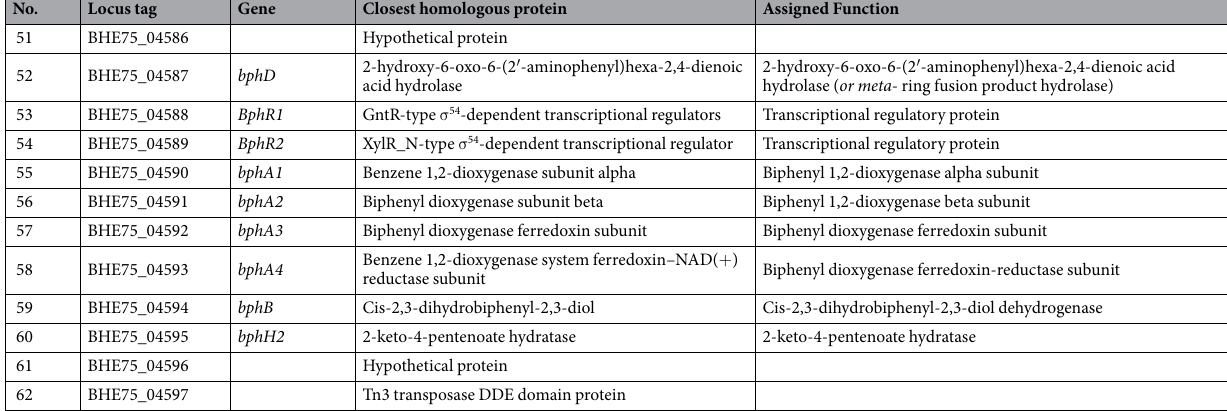
genes encoding the complete lower biphenyl ( bph ) pathway were found, including a 2-keto-4-pentanoate hydratase ( bphH1 ), an acetaldehyde dehydrogenase ( bphJ ) and a 4-hydroxy-2-oxovalerate aldolase ( bphI ). Denef et al . 27 have shown that a similar gene cluster in Burkholderia xenovorans LB400 was responsible for the transformation of 2-hydroxypenta-2,4-dienoate (produced by the hydrolysis of the 2-hydroxy-6-oxo-6-phenyl– 2,4-hexadienoic acid) to acetaldehyde and pyruvate. A transcriptional regulatory gene ( oppR ) showing high homology to a XylR_N superfamily of σ 54 -dependent transcriptional regulators was identified upstream of oppD1 (Table 1). This is in accordance with the regulation of the hpbCAD operon in P. azelaica which was operated by a σ 54 -dependent XylR/DmpR transcriptional regulator 26 . Operon 4 encodes an incomplete upper bph pathway (for the transformation of biphenyl to BA and 2-hydroxypenta-2,4-dienoate). This consists of bphA1A2A3A4 (multi-component biphenyl dioxygenase), bphB ( cis -biphenyl dihydrodiol dehydrogenase) and bphD (2-hydroxy-6-oxo-6-(2 ′ -aminophenyl)hexa-2,4-dienoic acid hydrolase), only missing bphC (2,3-dihydroxybiphenyl dioxygenase). The latter is known to be responsible for the transformation of biphenyl-2,3-diol to 2-hydroxy-2,4-pentadienoate and benzoate 28 . The upper bph pathway is ubiquitous in soil bacteria 29 and is usually found on transposable elements 30 . A second bphH2 and a gene encod- ing a second flavin-dependent monoxygenase (putative oppA2 ) were both located at the 5 ′ end of this operon. Two putative transcriptional regulatory genes were identified upstream of the bph genes ( bphR1R2 ). Phylogenetic analysis of the proteins encoded in the four catabolic operons provided insights into their origin and evolution. Operon 1 proteins (i.e. BenA, CatA, PcaD presented as indicative enzymes of the whole operon) clustered within the genus Sphingomonas and more specifically with proteins from a homologous operon of the HCH-degrading strain Sphingomonas MM1 31 (Supplementary Fig. S1). Their orthologs from operon 2 clustered with proteins found in bacteria from the wider sphingomonad complex ( Sphingobium and Novosphingobium ) (Supplementary Fig. S1). In contrast, proteins encoded in operons 3 (OppC, OppD1D2) and 4 (BphA3, BphB) were associated with taxonomically distant bacteria ( Burkholderiaceae , Streptomyces sp.) (Supplementary Fig. S2). These results suggest that the ben/cat operon 2 was laterally acquired by a member of the sphingomonad com- plex via horizontal gene transfer, in line with its flanking by tranposases. Whereas operons 3 and 4 constitute a patchwork assembly, with operon 4 probably still undergoing evolution as indicated by the lack of the bphC gene. Based on the genomic analysis of the S. haloaromaticamans strain P3, a putative metabolic pathway is pro- posed (Fig. 2a), where OPP is transformed to BA and 2-hydroxypenta-2,4-dienoate (operon 3). These are further transformed to Krebs cycle intermediates through the ben/cat ortho cleavage pathway (operons 1 or 2) and the lower bph pathway (operon 3), respectively. The pathway proposed is similar to the metabolic pathway of OPP by the P. azelaica strain HBP1 with the sole difference of the meta cleavage of BA operated in strain HBP1 5 . Analytical determination of selected metabolic products of OPP. Key intermediate transforma- tion products of the proposed metabolic pathway of OPP were detected by HPLC. The degradation of OPP by S. haloaromaticamans was rapid and concurred with the formation of BA, which peaked at 17 h and rapidly reduced thereafter (Fig. 2b). 2,3-dihydroxybiphenyl, the first metabolic product of the pathway, and catechol, the prod- uct of BA oxidation, were transiently detected at low levels. The transient formation of 2,3-dihydroxybiphenyl and catechol is probably a function of the capacity of S. haloaromaticamans to transform these intermediates at rates higher than that of their formation. Previous studies with P. azelaica HPB1 and other catechol-degrading bacteria 26,32 have suggested that this metabolic strategy is a clever mechanism to overcome the toxicity of such metabolic intermediates to bacterial cells. Proteomic analysis. Proteomic analysis explored the role of the catabolic operons on the microbial transfor- mation of OPP and provided an overview of the cell adaptation responses of the P3 strain during the degradation of OPP and/or BA. The bacterium was grown under selective conditions with OPP, BA and succinate as sole car- bon sources and its proteome was analyzed at the mid-log phase of growth. This coincided with the near complete